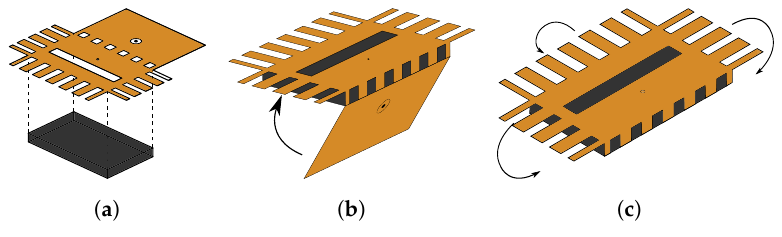
Figure 4. Antenna alignment procedure: steps 1 to 3. ( a ) Attachment of top (antenna slot) plane to substrate; ( b ) Folding around substrate; ( c ) Folding electrotextile around substrate and attachment of